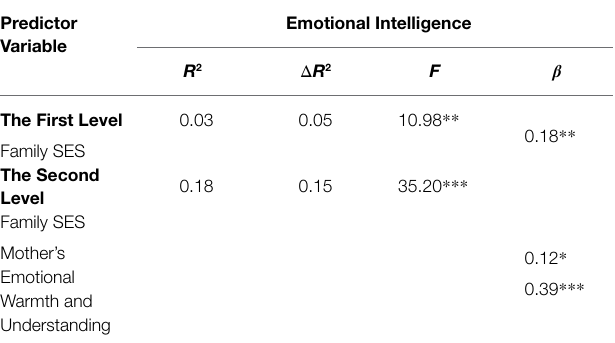
TABLE 10 | Regression analysis of total primary school students’ emotional intelligence on family socioeconomic status, mother’s emotional warmth, and